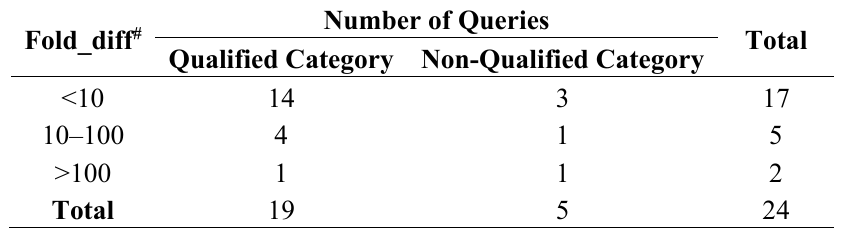
Table 5. Test set query categorization (qualified and non-qualified) based on k -NN model-based predicted class, and further divided based upon order of magnitude difference.